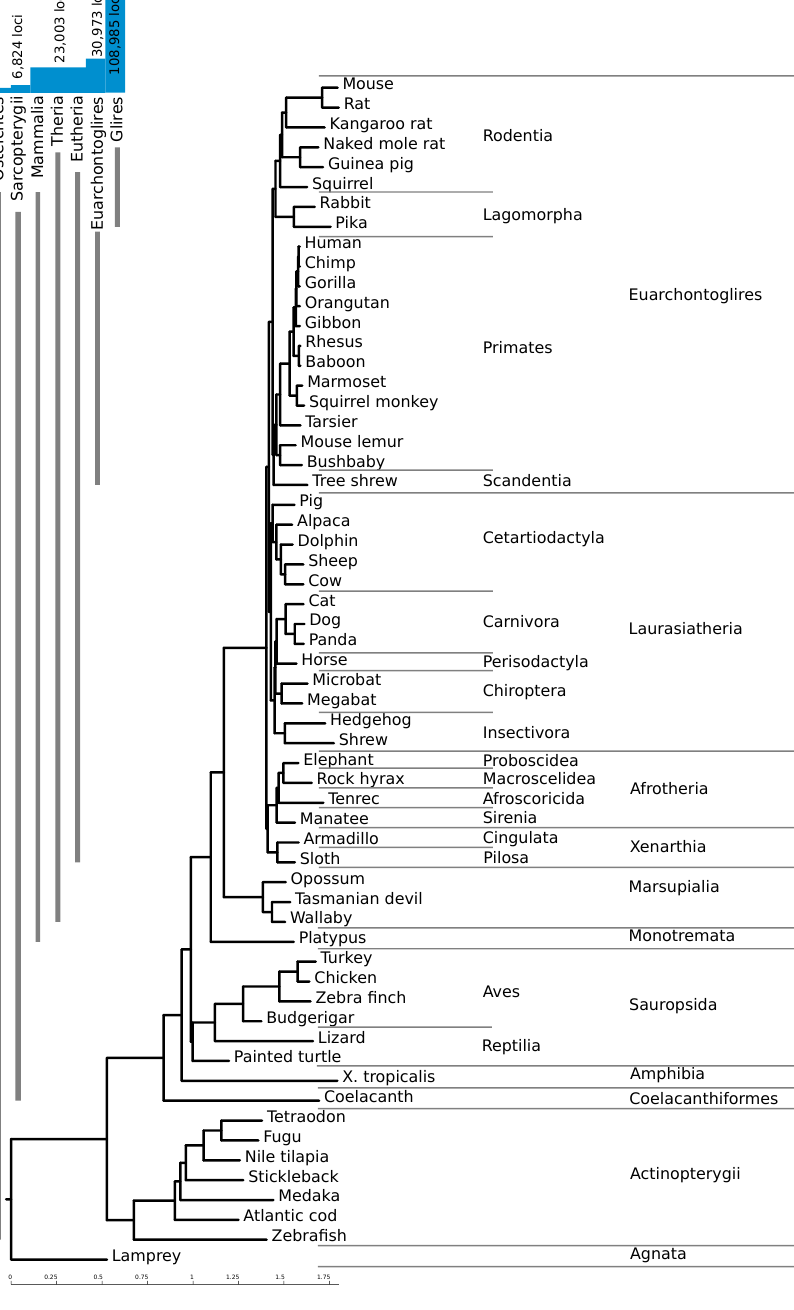
Figure 2. Phylogenetic tree of the 60 vertebrate species included in our screen, and number of high-confidence RNAz loci at different taxonomic levels. The tree corresponds to the one used for the multiz alignments provided by the University of Santa Cruz (UCSC) genome browser